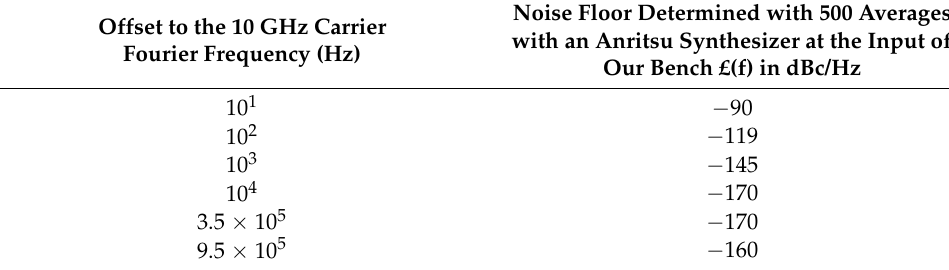
Table 3. Noise floor of the instrument. Offset to the 10 GHz